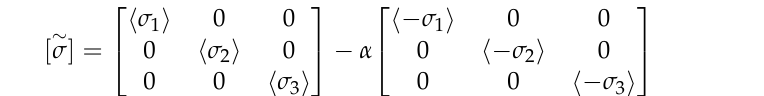
(unit: mm) Figure 2. Smooth round bar specimen for uniaxial tensile test (a: 80, 90, or 120). (unit: mm) Figure 3. Notched round bar specimen for tensile test (b: 80, 90, or 100, c: R1 or R3). Chromium steel SCr420H (in JIS) was applied as a material with high ductility. Table 1 lists the chemical composition of the material. Before the tensile tests, specimens were